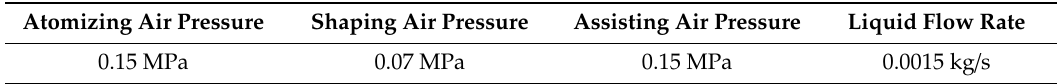
Table 1. Parameters for numerical simulation.